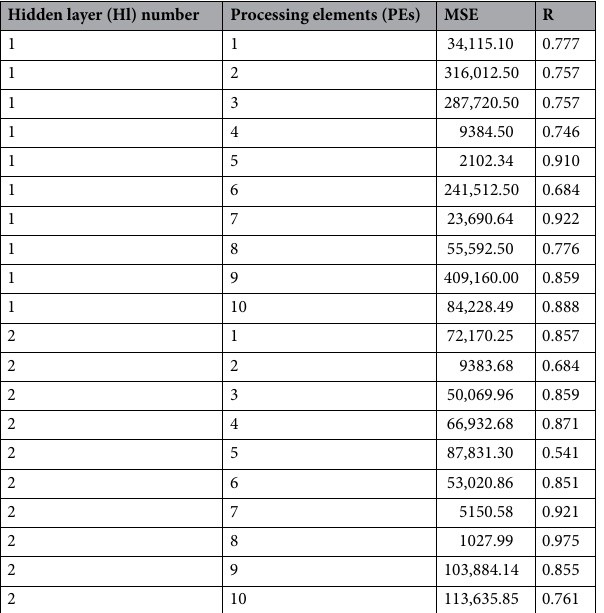
Table 4. The R and MSE (ton) performances of various ANN configurations using once trained for the dataset.